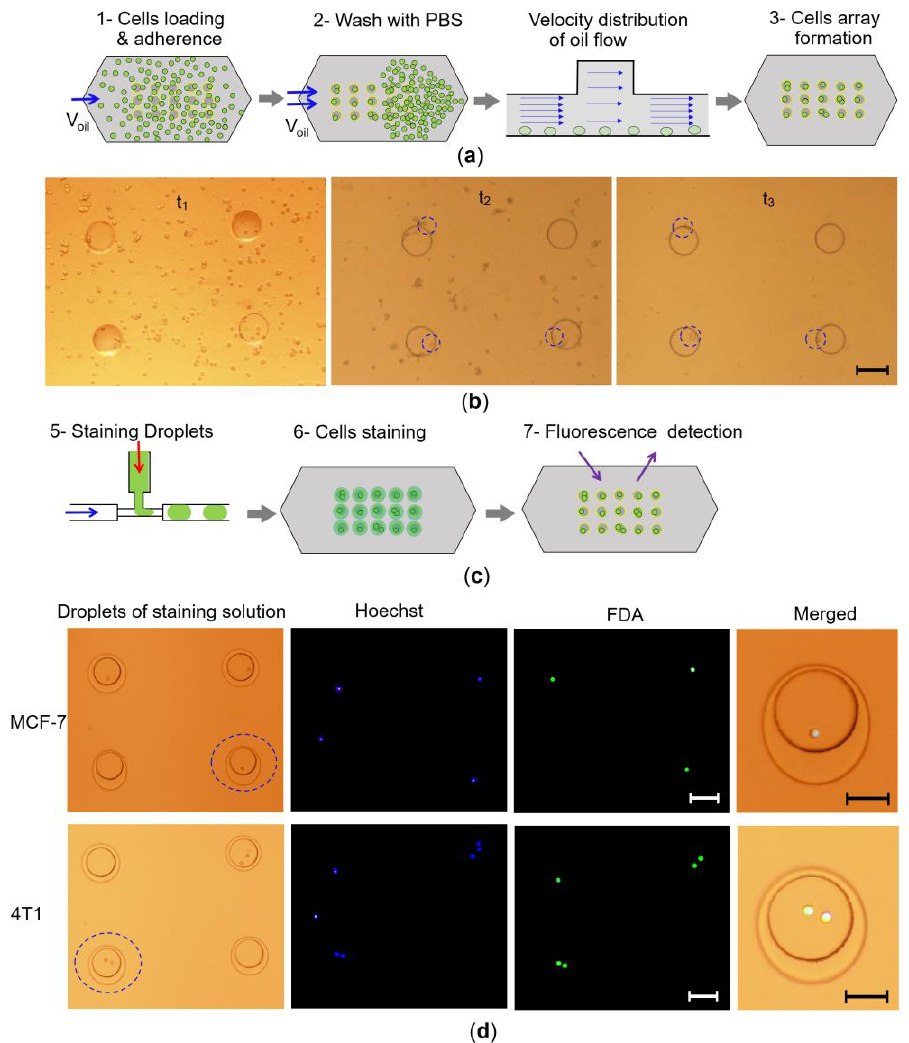
Figure 4. ( a ) Schematic diagram of cell loading, sedimentation, adherence to the bottom of the chamber and growth. Due to the oil flow velocity distribution, with an increasing flow rate of culture medium, single cells are successfully patterned according to the SEW array. ( b ) The bright-field pictures showed the adherence growth of MCF-7 cells on the fibronectin-modified surface. t 1 : cell suspension was cultured in the chamber under continuous medium flow. t 2 : cells uniformly adhered to the bottom under continuous medium flow at a relatively lower rate for 2 h. t 3 : after the culture medium flow rate was increased, single cells appeared in an arrangement corresponding to the cells marked by the dashed blue circles in t 2 . Scale bars: 100 μm . ( c ) Schematic diagram for staining single cells by loading various staining droplets; the cells can be viewed directly using a microscope. ( d ) The bright-field and fluorescence images of MCF-7 and 4T1 cell arrays were observed under a 10× objective lens, scale bar: 100 μm, while the merged images (marked by the dashed blue circles in the first column) were observed under larger magnification (2 0× objective), scale bars: 50 μm. These results provided early information on single cell morphology and viability. Bright droplet = staining solution, blue = cell nuclei (stained by Hoechst) and green = live cells (stained by FDA).